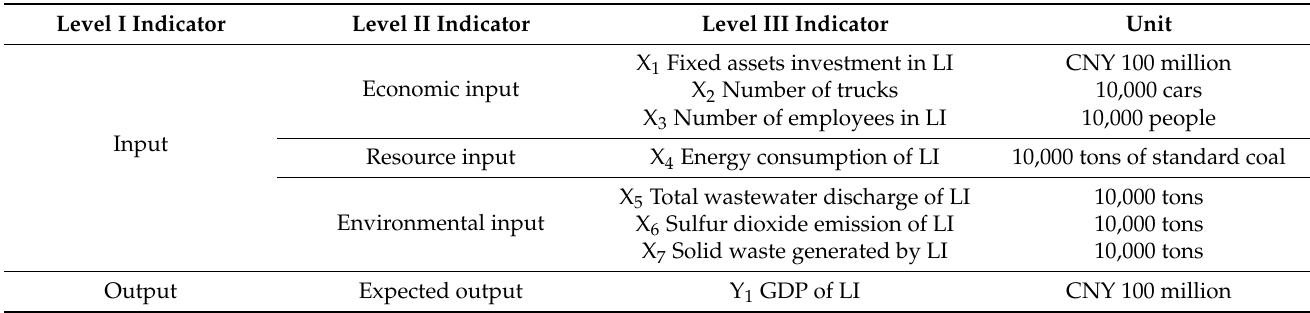
Table 1. Eco-efficiency evaluation index system for